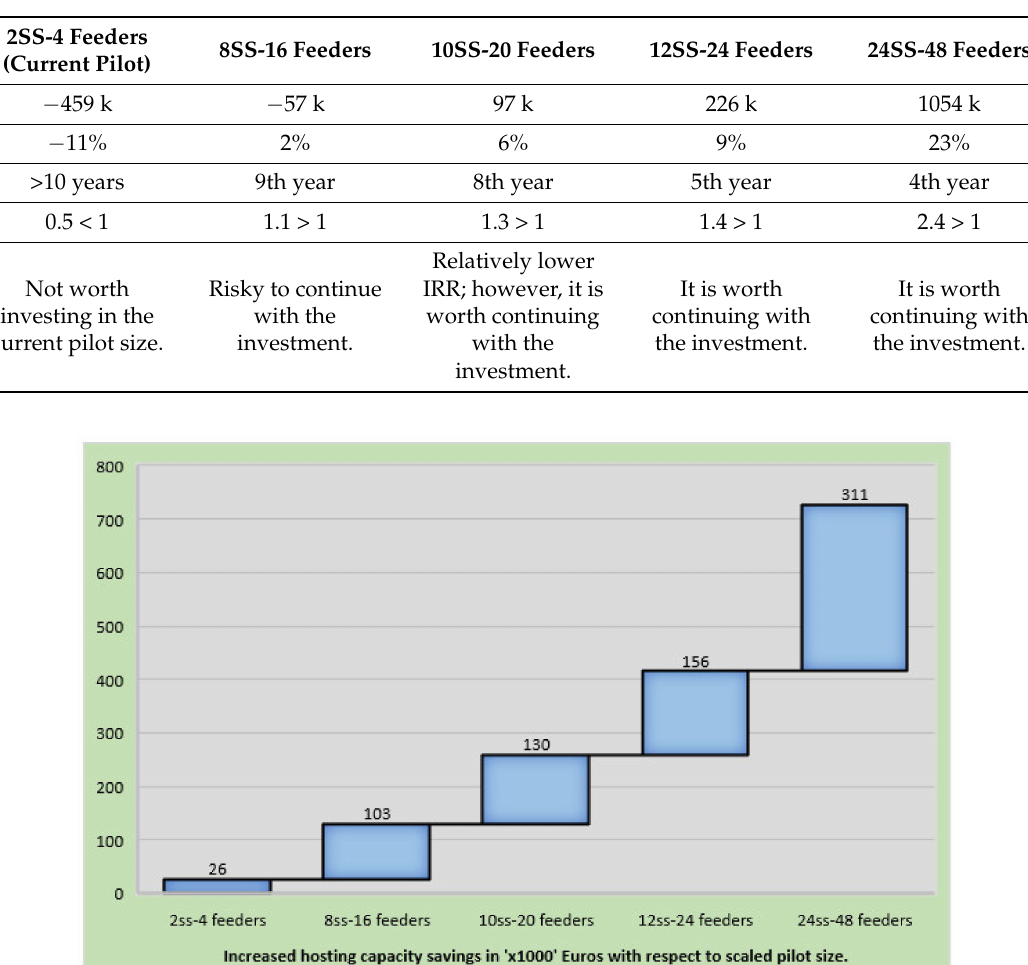
Figure 9. Increased hosting capacity with scale-up of RESOLVD pilot.